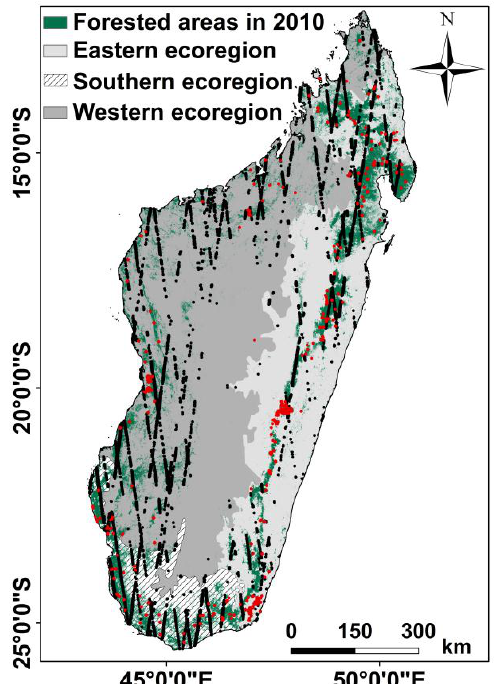
Figure 1. Madagascar, with the three ecoregions; forested areas in 2010 determined from Vieilledent’s Above Ground Biomass (AGB) map. Black points are the 48247 Geoscience Laser Altimeter System (GLAS) footprints located within forested areas. Red points correspond to field inventories.